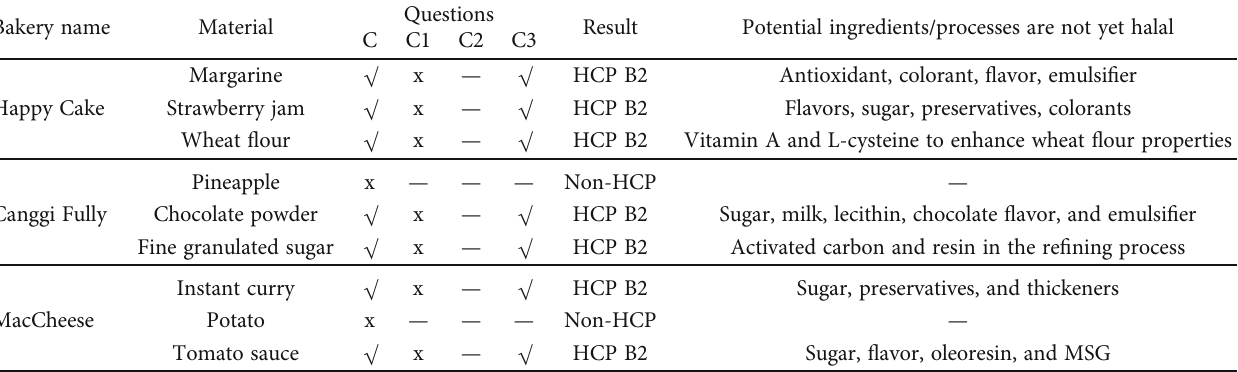
Table 3: HCP identi fi cation of vegetable material based on the decision